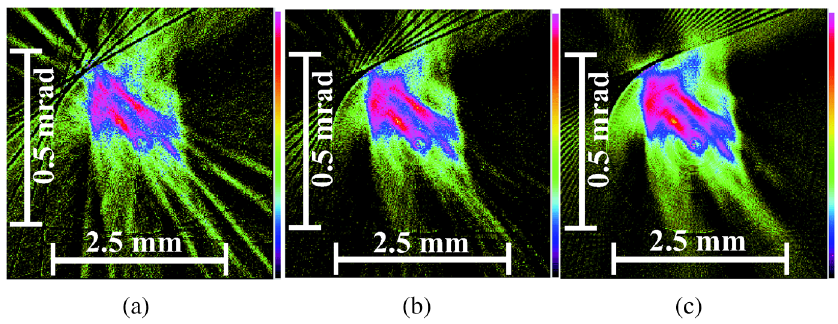
FIG. 3. (Color) Recovery of the phase-space density distribution of an actual beam. Different numbers of measured and interpolated projections are used for the Y - Y 0 tomographic recovery. (a) 16 measured /16 interpolated, (b) 32/32, (c)